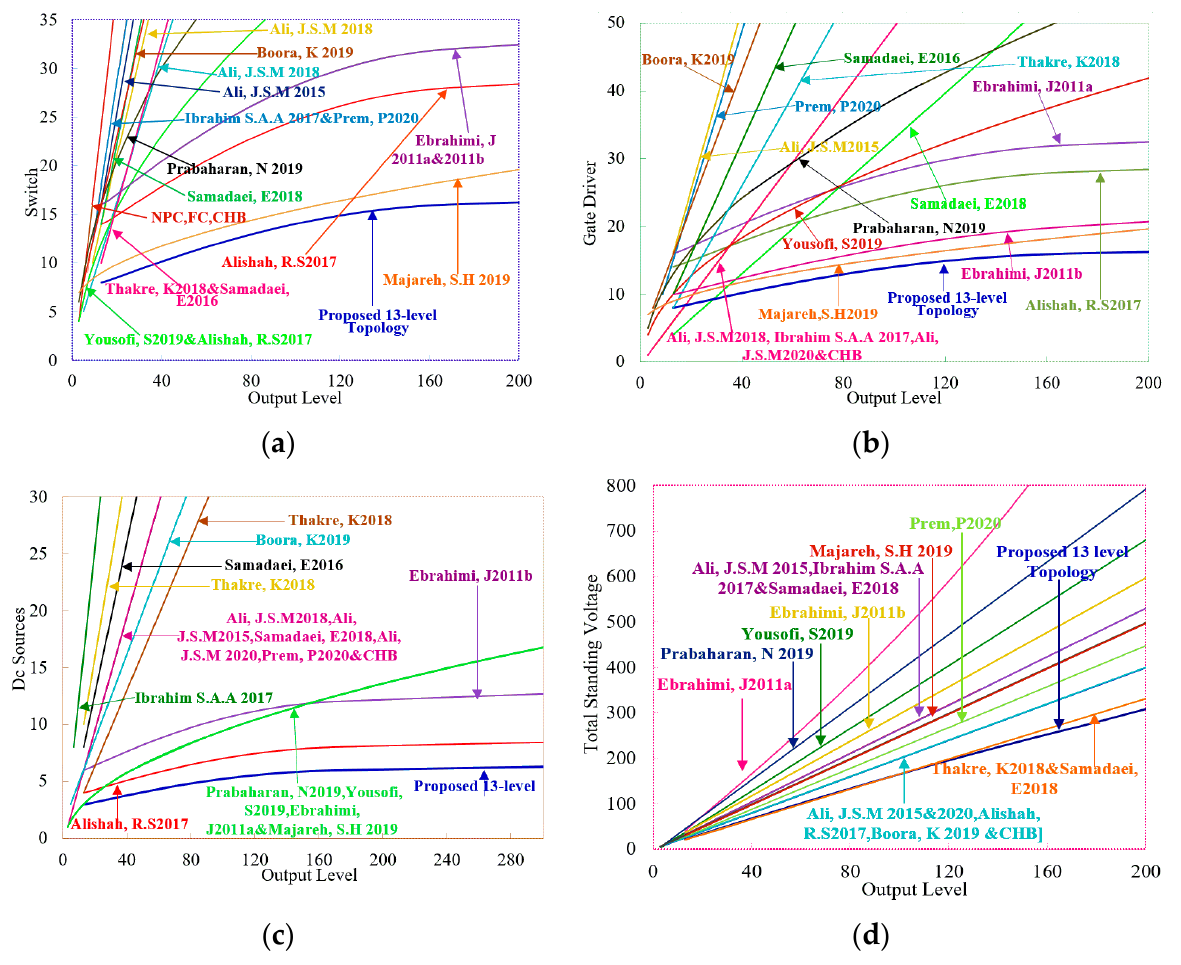
Figure 4. Comparison of performance parameters: ( a ) switch vs. output level, ( b ) gate driver vs. output level, ( c ) Dc sources vs. output level and ( d ) total standing voltage vs. output level.